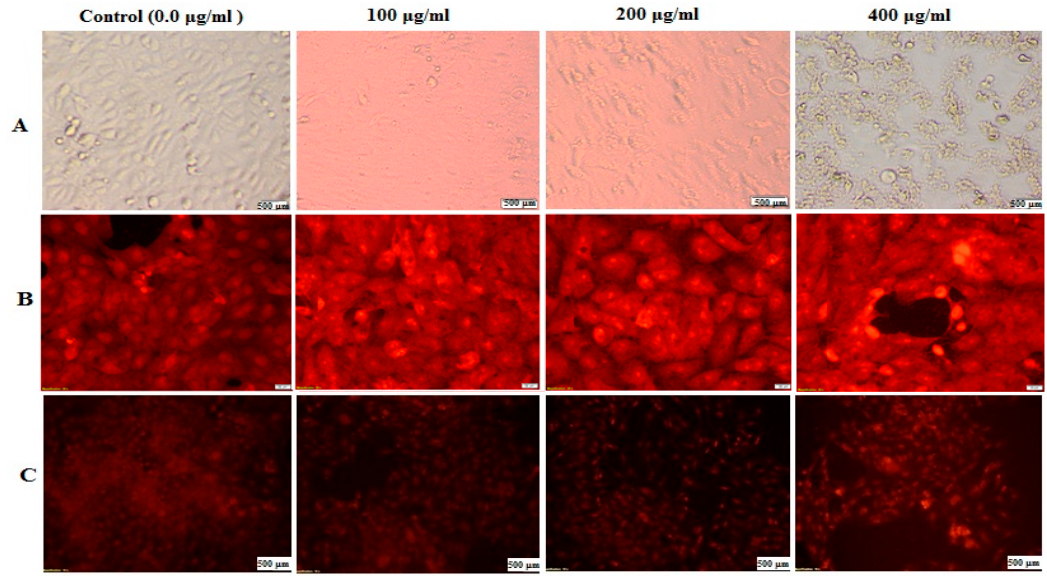
Figure 6. DSE effect at different concentrations of 0.0 µg/mL (control), 100 µg/mL, 200 µg/mL, and 400 µg/mL on HepG-2 cells using an inverted phase-contrast microscope: ( A ) Morphological modifications of the cells treated with DSE, ( B ) Fluorescence images of PI-stained cells, and ( C ) Fluorescence images of HepG-2 cells stained with ethidium bromide–acridine orange. Natural products are important for maintaining human health and are good bioprospecting sources for exploring new antitumor drugs. Therefore, the discovery of new antitumor candidates from low-cost and affordable sources is in continuous demand. Al-Sheddi (2019) [33] demonstrated the antitumor properties of seed extract from Phoenix dactylifera against liver, lung, and breast cancer cells. In addition, Rezaei (2015) [34] reported the anticancer potential of DSE against colorectal cancer cells. Another study revealed the anticancer potential of DSE against breast and liver cancer cells [35]. Date seeds are rich in polyphenols, phenolic acids such as protocatechuic acid, caffeoyl shikimic acids, and flavan-3-ols compounds, including catechin, epicatechin, and polymeric proanthocyanidins. Natural polyphenols have previously been shown to inhibit several important biochemical routes contributing to cancer development [36]. Additionally, polyphenols may protect living cells from ROS damage and boost immunity. In a previous study, Habib et al. (2014) [37] documented the anticancer activity of date seed against pancreatic cells. Hilary et al., (2021) [35], found that date seed enhanced the anticancer activity, but a high concentration of more than 1000 µg/mL was used with IC 50 values of 678.4 µg/mL and 662.2 µg/mL on MCF-7 and HepG-2 cells, respectively, after an exposure time of 48 h. However, Al-Zubaidy, (2016) [38] revealed the anticancer activity at a low concentration of polyphenols extracted from date seed with chloroform against MCF-7 cells with IC 50 determined to be 3.18 µg/mL after 48 h of treatment. Recently, Khan et al. (2022) [39] demonstrated that DSE exhibits anticancer activity against the MDA-MB-231, MCF-7, and HepG-2 cells with IC 50 values of 85.86, 99.9, and 122.3 µg/mL after treatment for 48 h, respectively. Furthermore, the DSE enhanced the expression level of p53 and suppressed the expression levels of both p21 and BCl-2. The gene of BCl-2 is an anti-apoptotic gene that inhibits the initiation steps of the apoptosis pathway and programmed cell death [40]. However, p53 is a crucial regulatory protein in the enhancement of apoptosis that is mediated after DNA damage by anticancer drugs [41], which consequently leads to the arrest of cell cycle growth in the apoptosis phase or sub-G1 phase. Therefore, our results suggested that the date seed extract had a higher